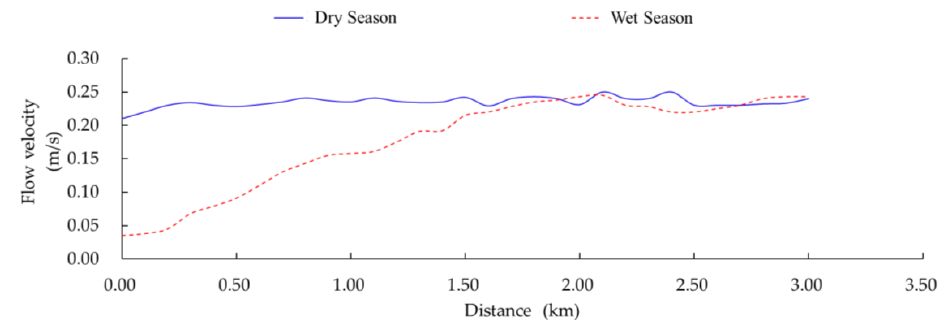
Figure 7. Flow velocities along Fu River during the dry (March) seasons and wet (July) as a function of distance from the lake’s inlet.